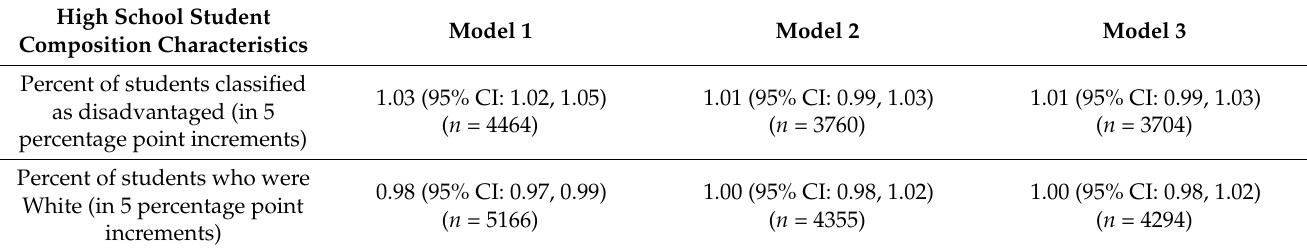
Table 3. Odds ratios for obesity at age